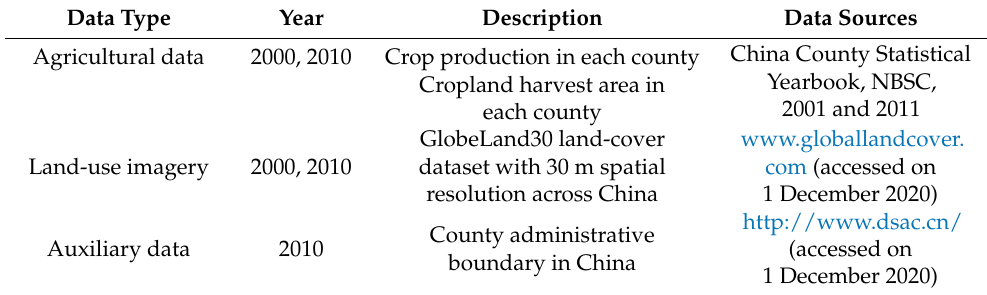
Table 1. Data used in this paper.